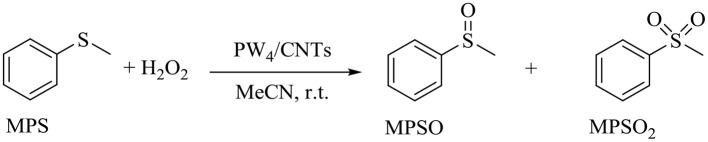
Oxidation of MPS with H2O2 in the presence of PW4/CNTs.